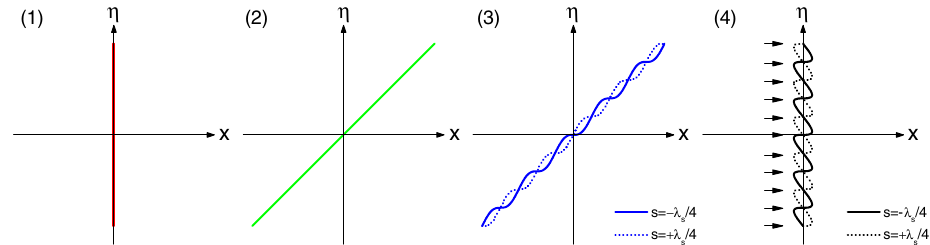
FIG. 2. Electron distributions in the phase space at four different positions indicated in Fig. 1. The solid and dashed lines in (3) and (4) correspond to s ¼ þ λ s = 4 and s ¼ − λ s = 4 ,